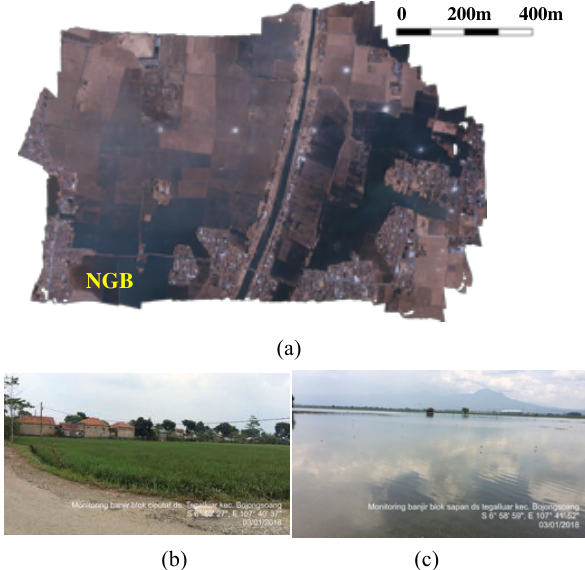
Flooded situation at Site2.